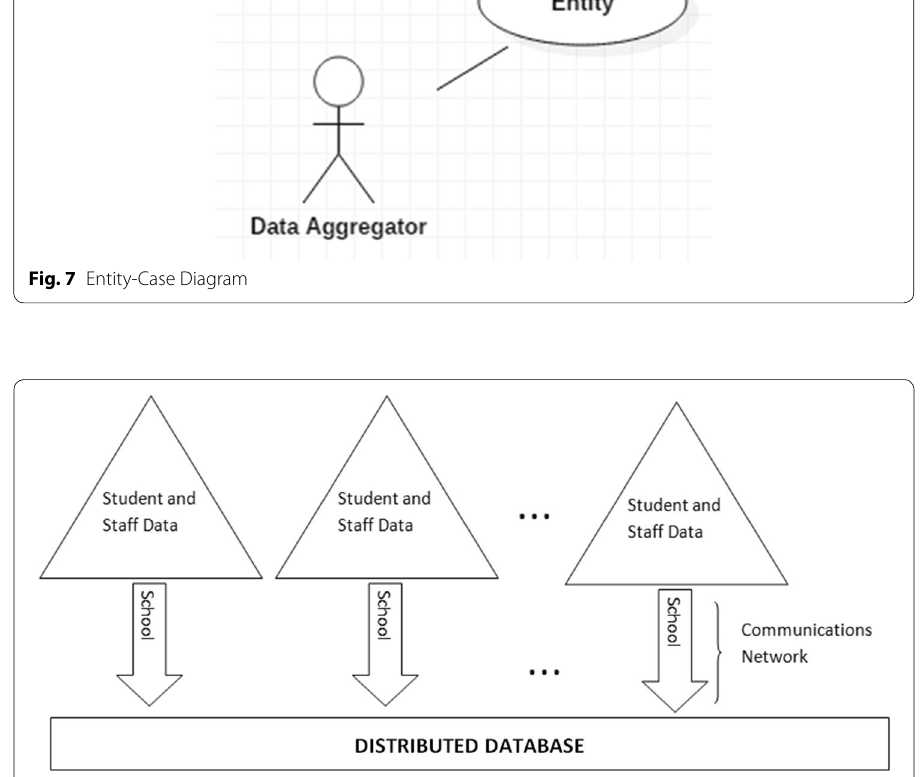
Fig. 8 Architecture of a Data Collocation Model of Multiple Schools